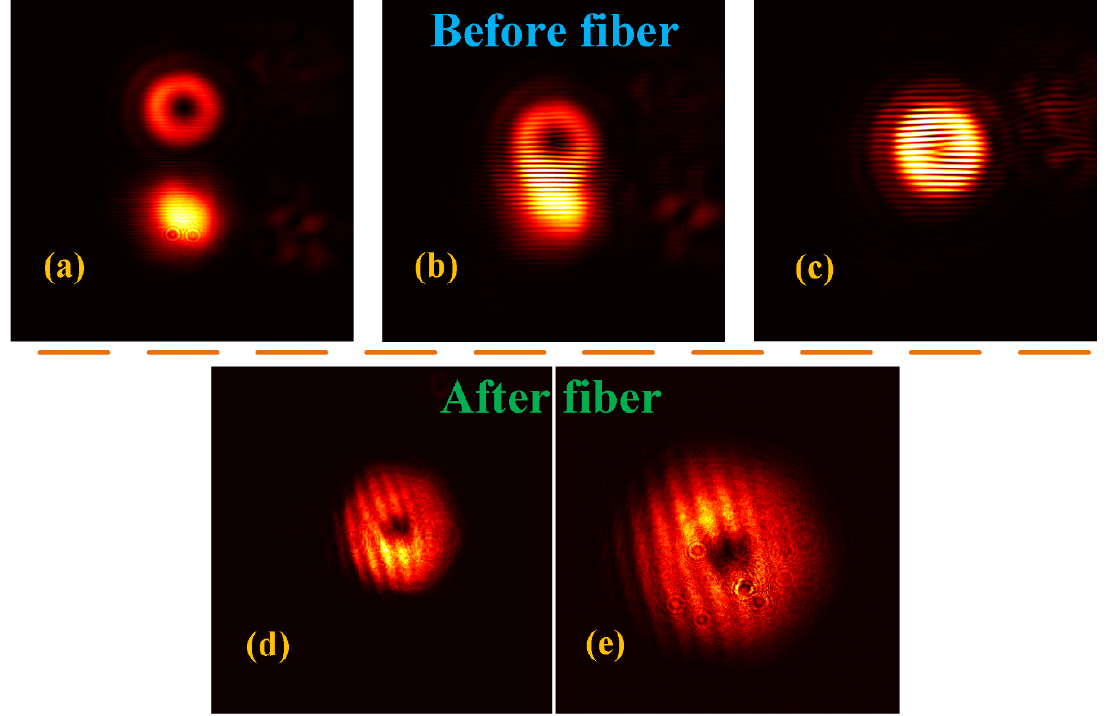
Figure 4. ( a , b , c ) Interference pattern of a L = +1 doughnut-shaped OAM beam with a reference Gaussian beam as they progressively merge to generate a single fork pattern before (Top row) and ( d , e ) after propagation in the fiber (Bottom row).